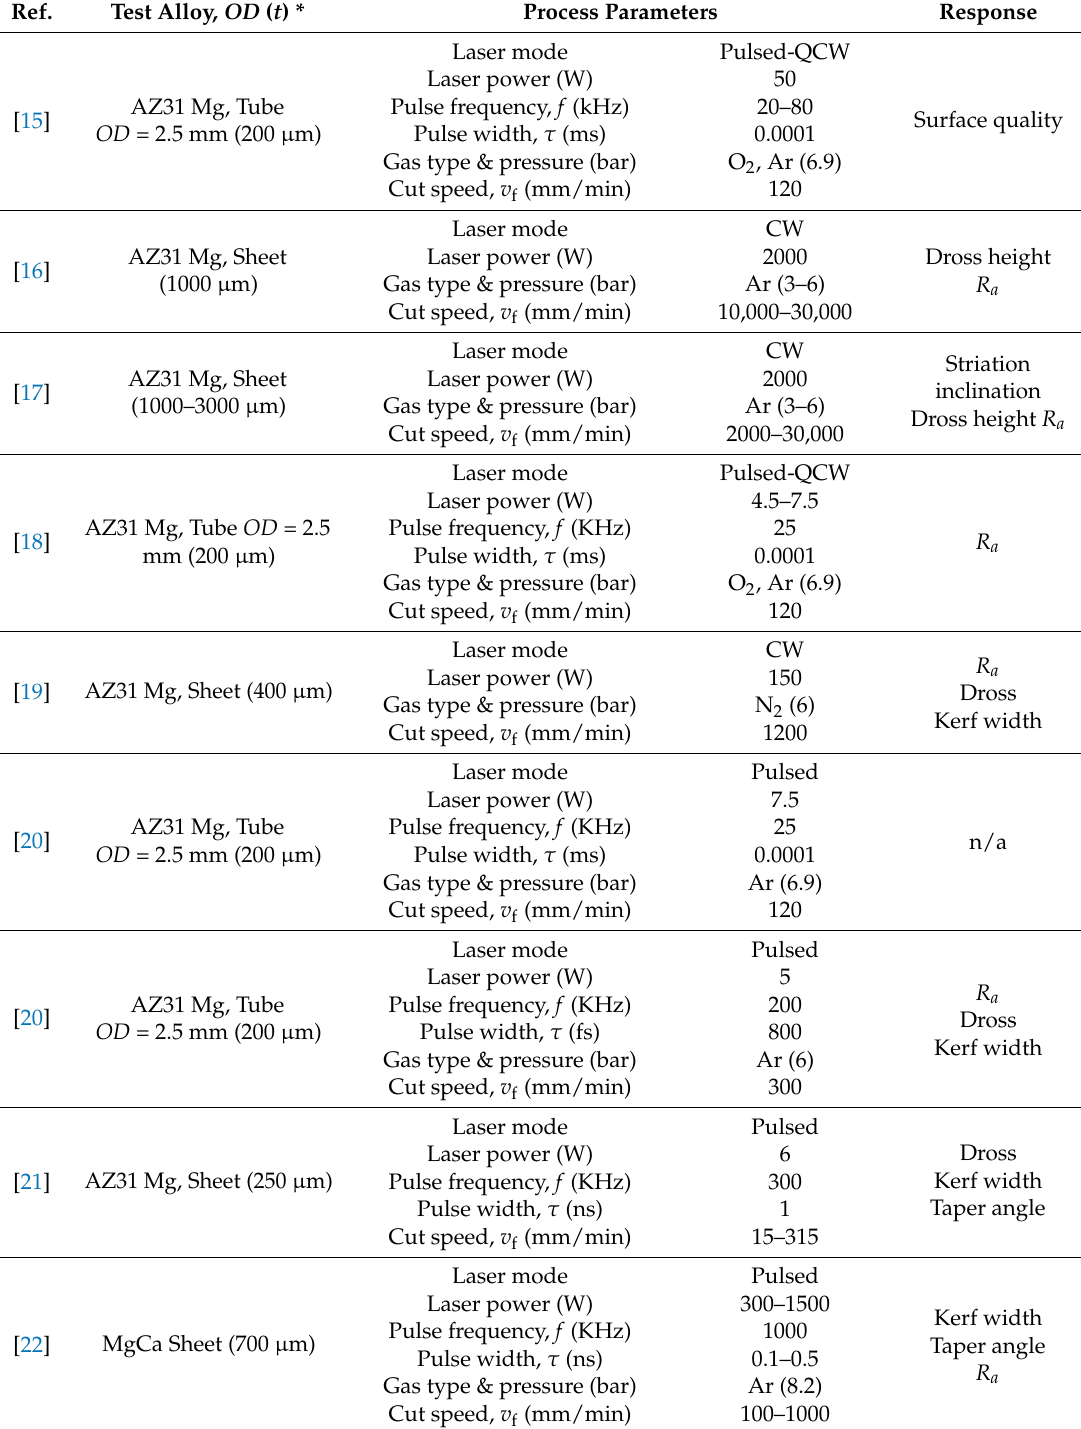
Table 1. Review for fiber laser cutting of AZ31 magnesium alloy.